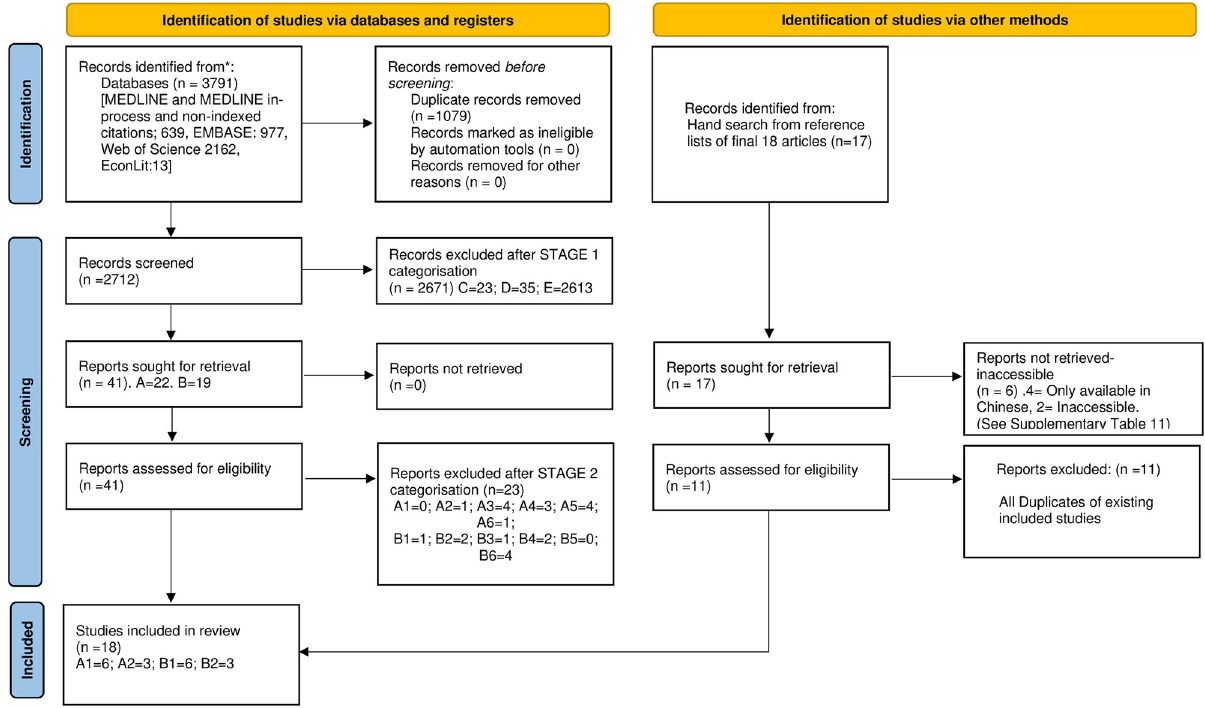
Fig 1. PRISMA flowchart depicting the process of study selection